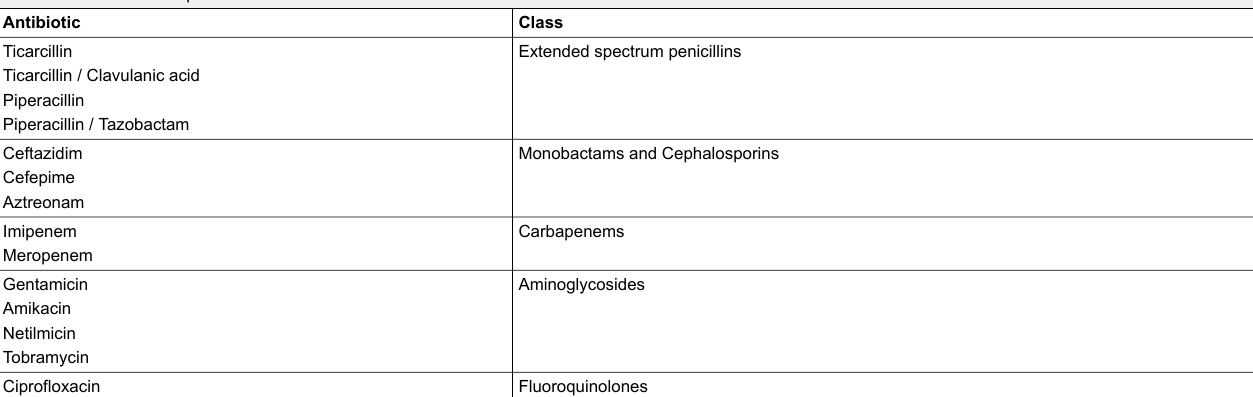
Table 1: Classes of anti-pseudomonas